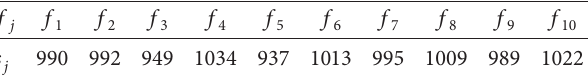
Table 5: Size files values for the case study.